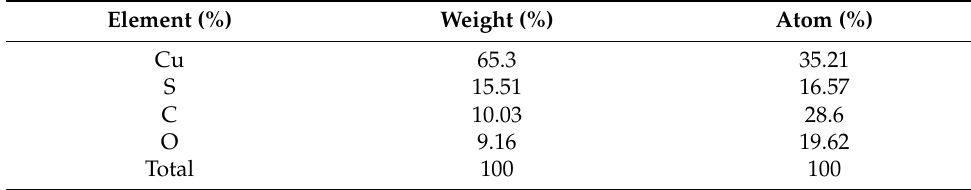
Table 1. Elemental analysis results of the P1.2 film.